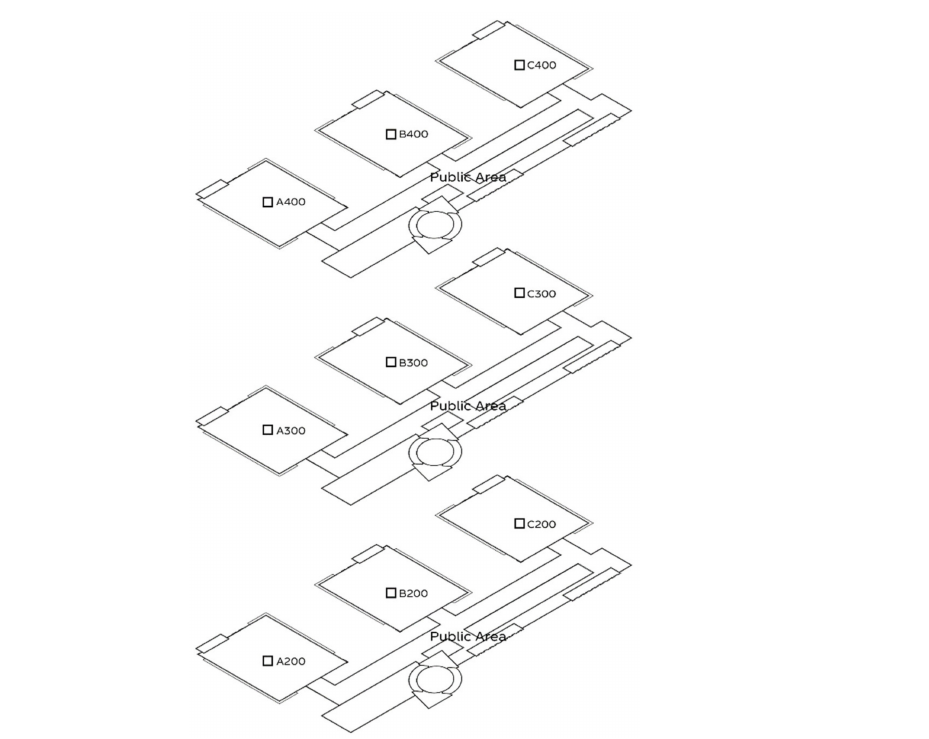
Figure 9. Regional distribution map of Shanghai Jiao Tong University Library.